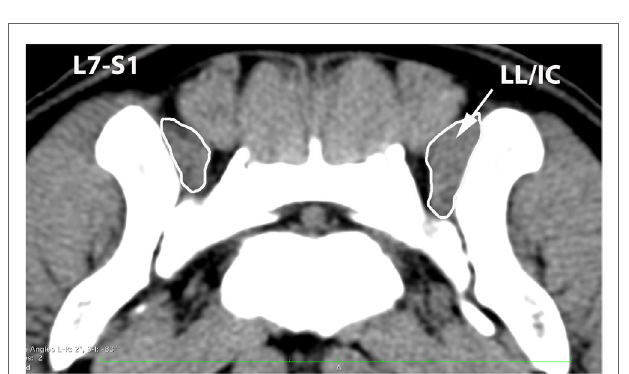
FIGURe 9 | transverse Ct image at the level of L7–s1, illustrating margins of the combined longissimus lumborum/iliocostalis (LL/IC) muscle group .